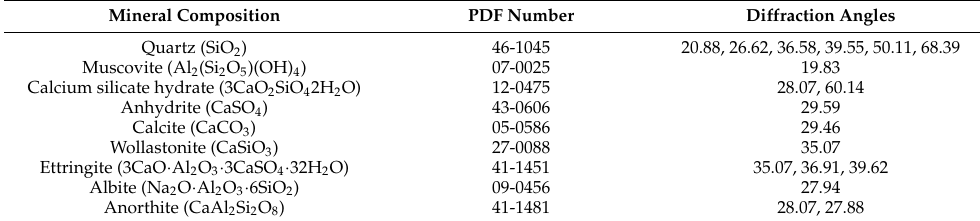
Figure 10. X-ray diffraction images of specimens under different erosion environments of ( a ) water and ( b ) sulfate solution. Table 6. Results of X-ray physical phase